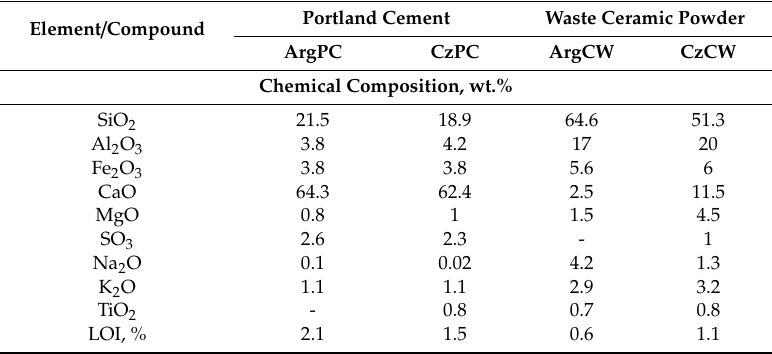
Table 1. Chemical and physical characteristics of used